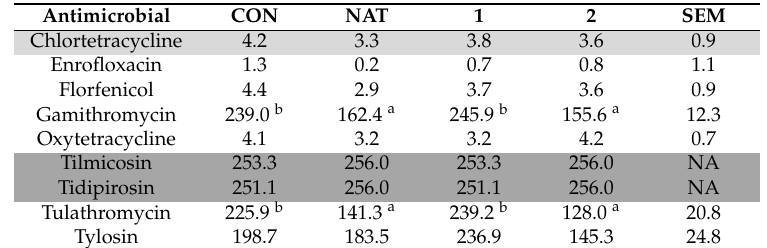
Table 8. E ff ect of management z and year of study on minimum inhibitory concentrations (MICs) of antimicrobials for isolates of Mycoplasma bovis ( n = 61). Least square means are reported for antimicrobials showing unimodal distributions (not shaded), and selected bimodal distributions (light grey shading). Arithmetic means are reported for other antimicrobials (dark grey shading). MICs < or > than the range of concentrations evaluated were estimated as the next lower or higher concentration commonly used on the Sensititre plate prior to statistical analyses.